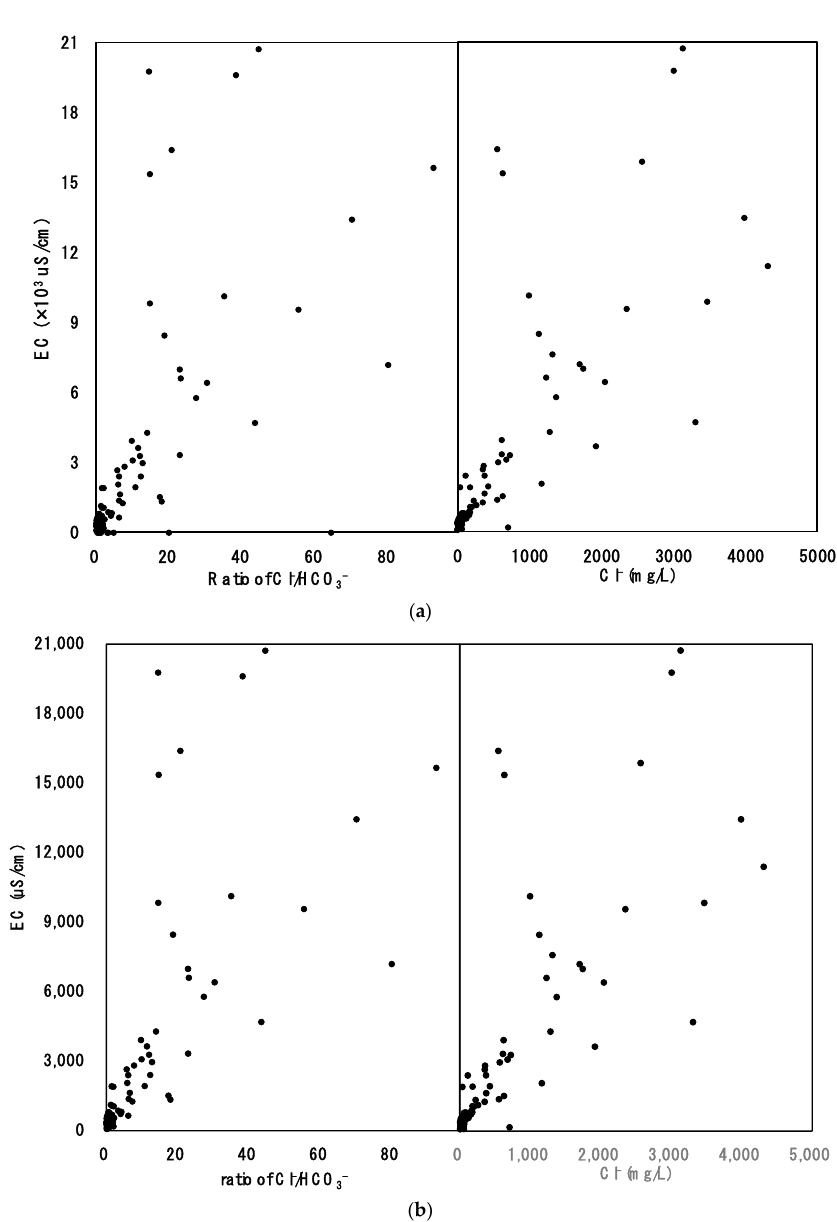
Figure 3. Comparison between ( a ) ratio of Cl − / HCO 3 − to electrical conductivity (EC) and ( b ) chloride ion (Cl − ) to electrical conductivity for the seawater of Korea, provided by the Ministry of Agriculture, Food and Rural A ff airs and Korea Rural Community Corporation